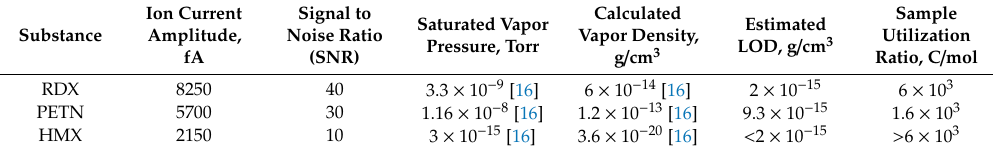
Figure 6. Amplitude of ion current in peaks from saturated vapor of the explosives at 25 °C: ( a ) RDX; ( b ) PETN; ( c ) HMX. Table 3. Comparison of laser FAIMS capabilities of detecting explosives in vapor phase at 25 °C.